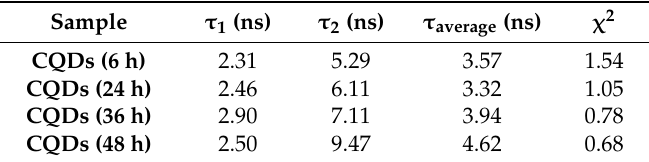
Table 4. The lifetime components of CQDs (12 h), CQDs (24 h), CQDs (36 h) and CQDs (48